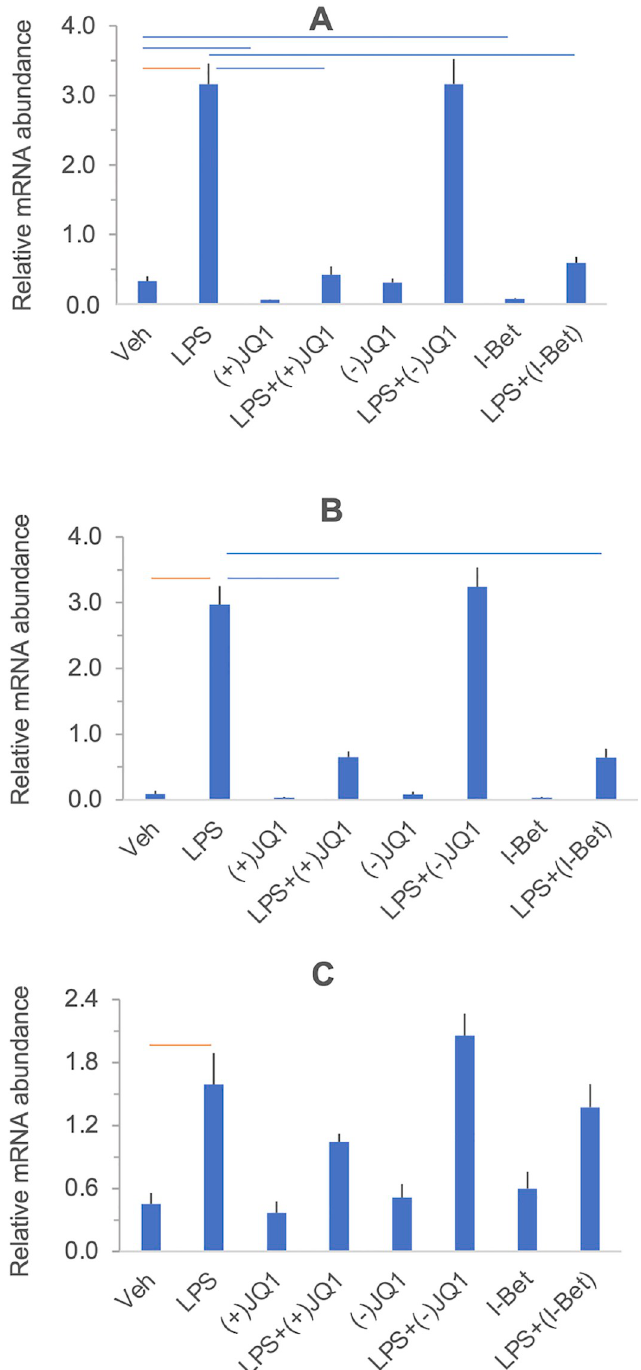
Fig 3. The effect of LPS and BET inhibitors on IL6 (Panel A), CXCL8/IL8 (Panel B) and TNF (Panel C) mRNA expression in DSCs. Primary DSC cultures were treated with vehicle, LPS, (+)-JQ1, (-)-JQ1, I-BET-762, and their combinations as indicated under the columns. Messenger RNA relative abundance was determined by qRT-PCR. Significant differences (at 5% FDR), highlighted in the heatmap in Fig 1, are indicated by the horizontal orange and blue lines. Further details and data presentation are described in Legend to Fig